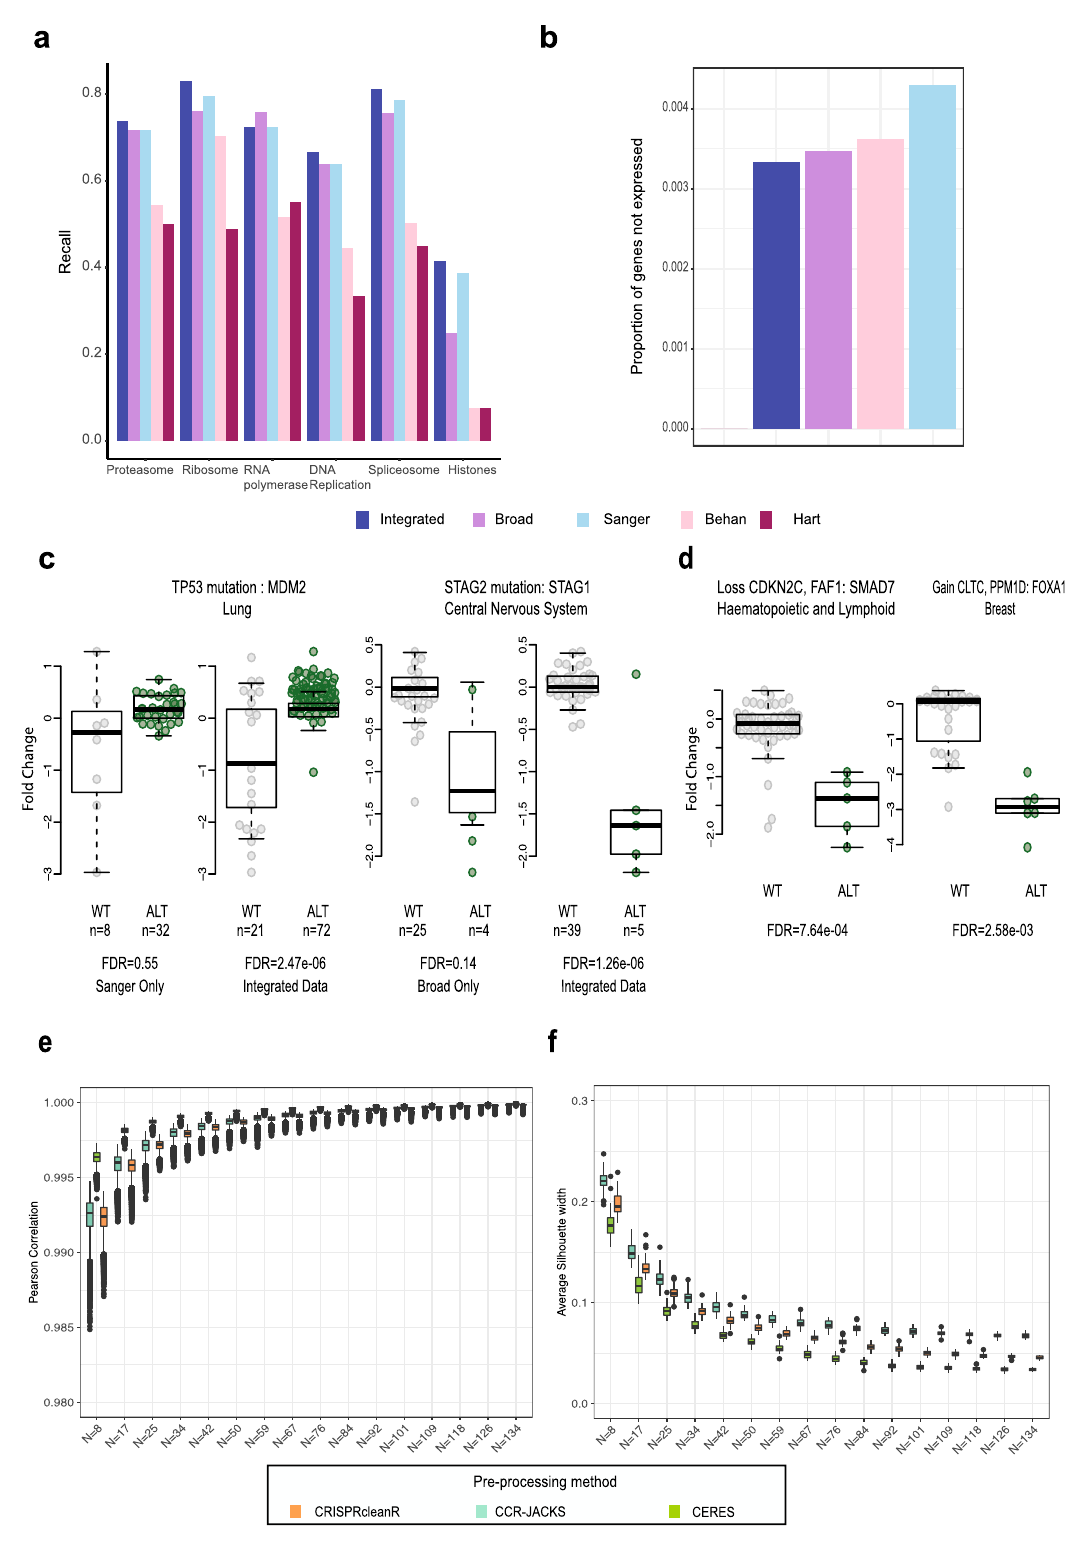
datasets are corrected for batch effects allowing for their joint analysis. Following integration, dependency pro fi les of cell lines from the same tissue lineage and cancer-speci fi c subtypes show good concordance. Our integrated datasets cover a greater number of genetic dependencies, and the increased diversity of screened models allows additional associations between bio- markers and dependencies to be identi fi